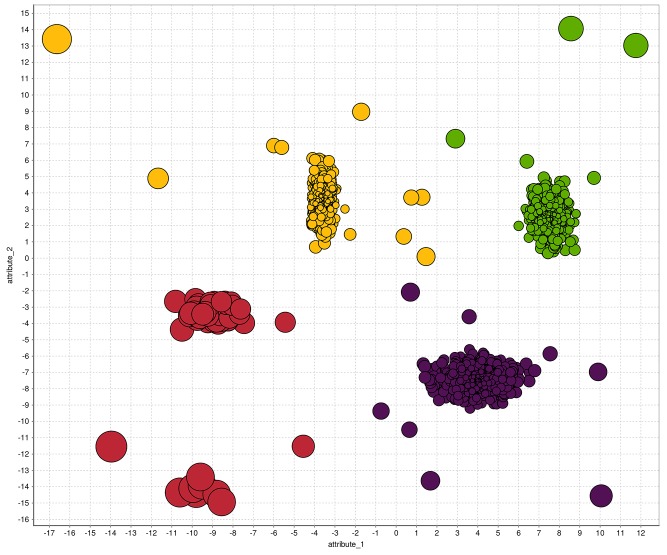
A visualization of the results for the uCBLOF algorithm.The anomaly score is represented by the bubble size, whereas the color corresponds to the clustering result of the preceded k-means clustering algorithm. Local anomalies are obviously not detected using uCBLOF.